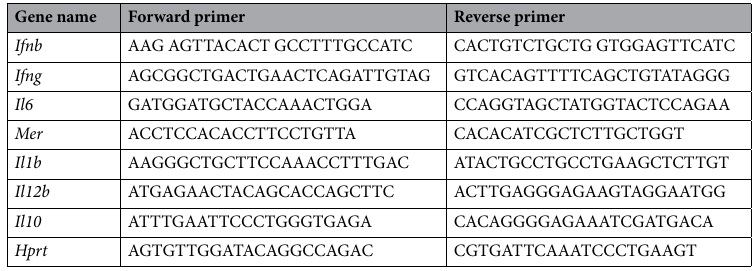
Table 1. RT qPCR primer